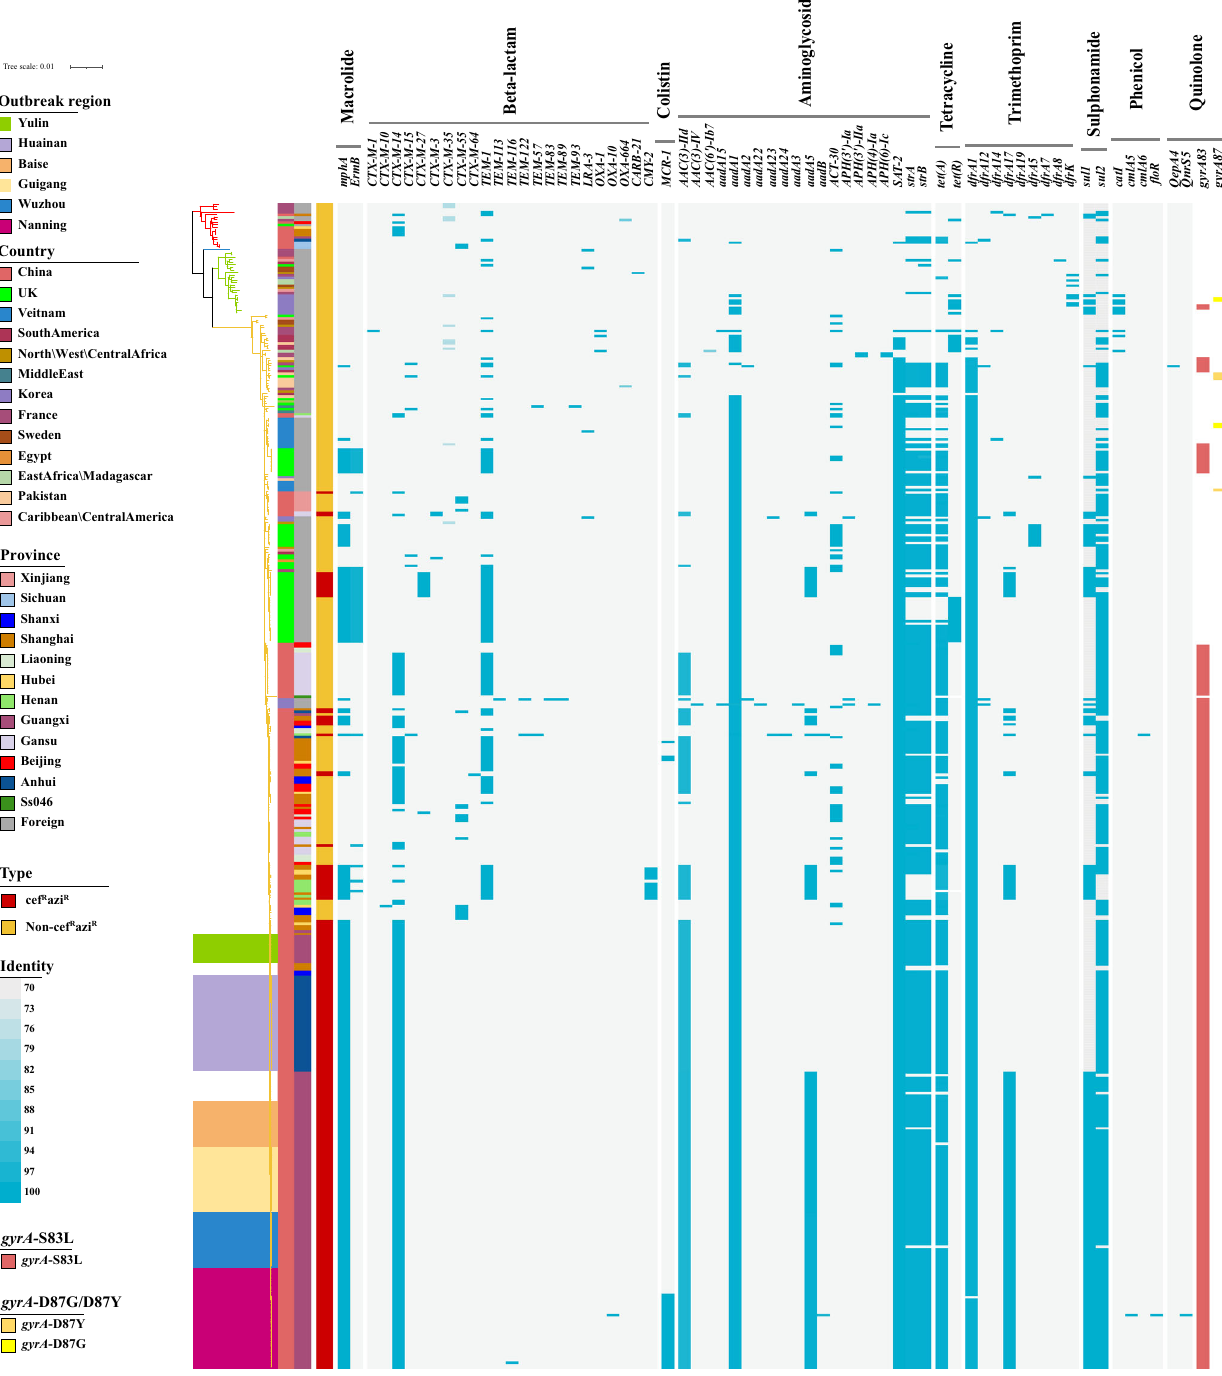
Fig. 3 | Phylogeny of the global S. sonnei isolates with a heatmap showing the distribution of AMR determinants. The region covered by color patches on the evolutionary tree represents the outbreak strains in different regions, and the two bands at the left of the heatmap indicate the information of the country and pro- vince of the strains, respectively. Blue stripes represent the identity of different